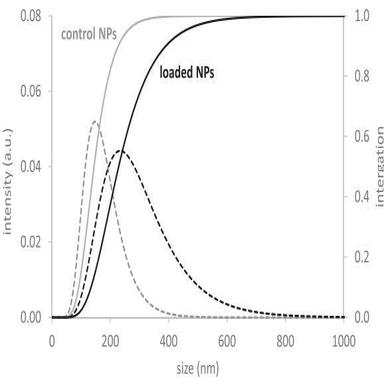
Comparison of control (grey line) and loaded nanoformulations (black line) signal using batch-mode DLS.